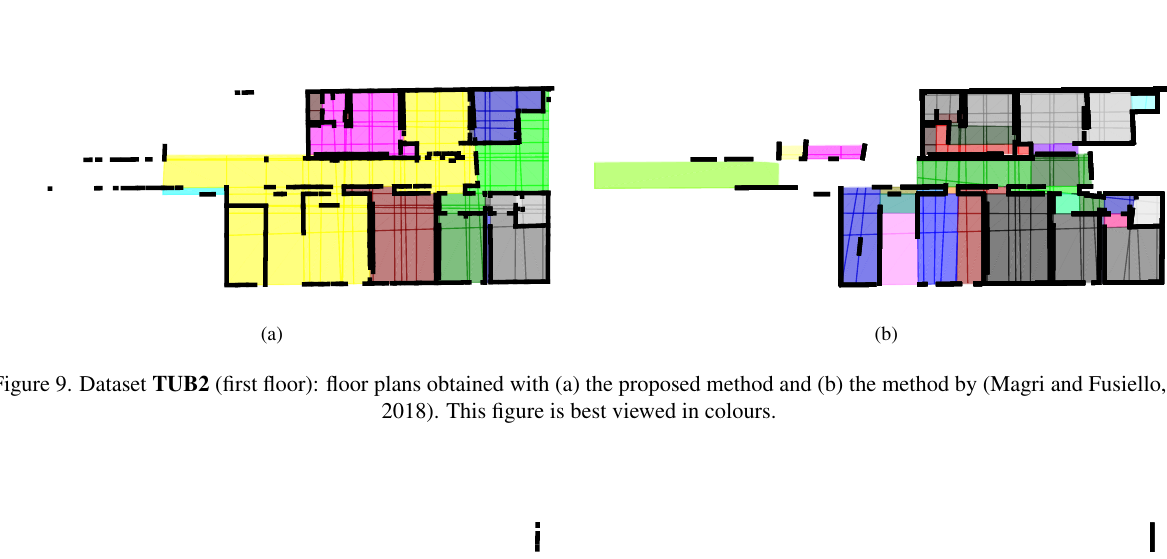
Figure 8. Dataset TUB1 : floor plans obtained with (a) the proposed method and (b) the method by (Magri and Fusiello, 2018). This figure is best viewed in colours.